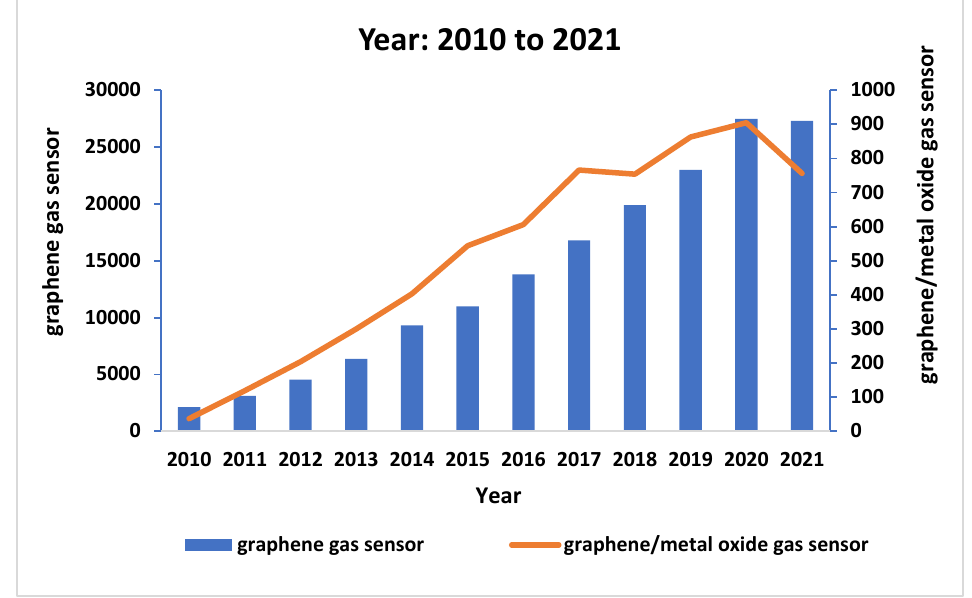
Figure 2. Research progress on the development of graphene/metal oxide as a chemical sensor from 2010 to 2021.